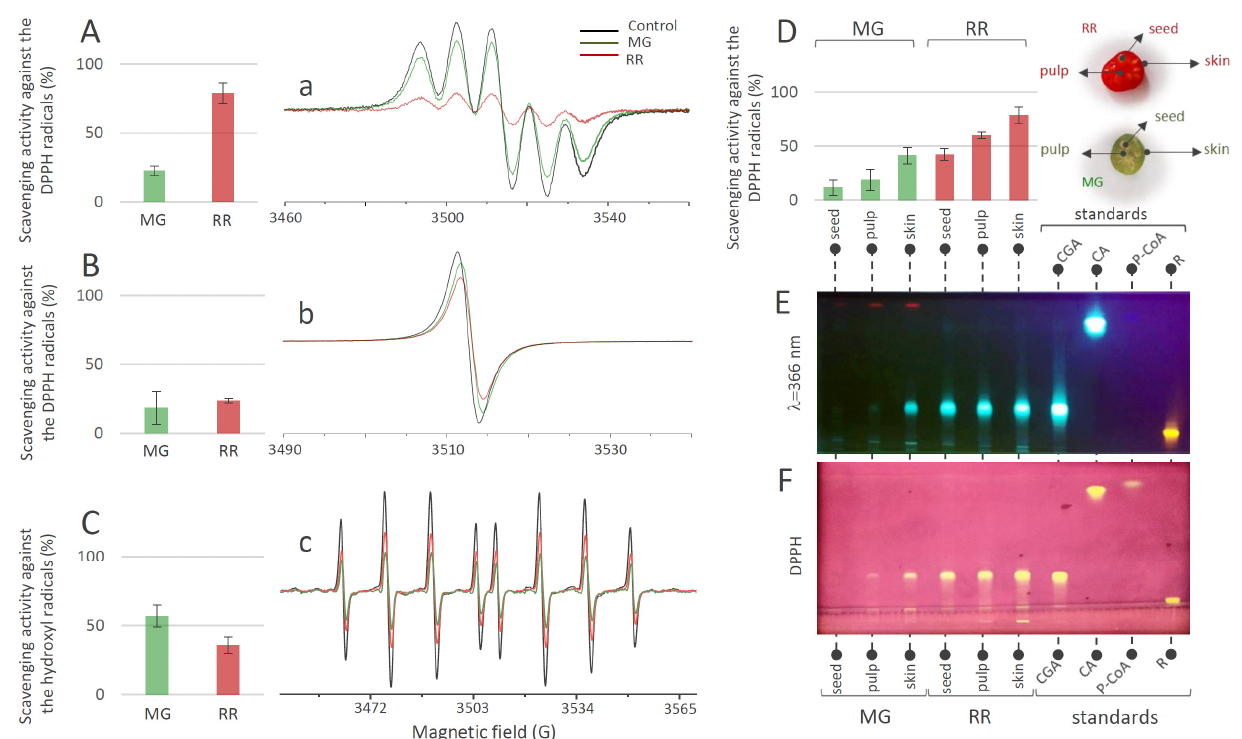
Figure 4. DPPH scavenging activity (%) obtained 2 min after the addition of DPPH into the bittersweet fruits system containing ( A ) MeOH extracts or ( B ) water extracts of MG (green bars) and RR (red bars), and representative EPR spectra of ( a ) DPPH radical in MeOH (black line), and in reaction with the MG (green line) and RR (red line) fruit MeOH extracts system, and ( b ) DPPH radical in H 2 O (black line), and in reaction with the MG (green line) and RR (red line) fruit water extracts system. ( C ) • OH scavenging activity (%) obtained 2 min after the • OH generation in the Fenton reaction system containing H 2 O extracts of MG (green) and RR (red) bittersweet fruits, and ( c ) representative EPR spectra of DEPMPO/OH spin adducts obtained in the Fenton reaction system without (black line) and in reaction with the MG (green line) and RR (red line) fruit water extracts. ( D ) DPPH scavenging activity (%) recorded 2 min after the addition of DPPH into the system containing MeOH extracts of the skin, pulp, and seeds of MG (green) and RR (red) bittersweet fruits. Values are the means of three biological replicates, and error bars represent signal-to-noise ratio. ( E ) HPTLC of MeOH extracts of seed, pulp, and skin of MG and RR bittersweet berries at 366 nm, and ( F ) corresponding HPTLCDPPH